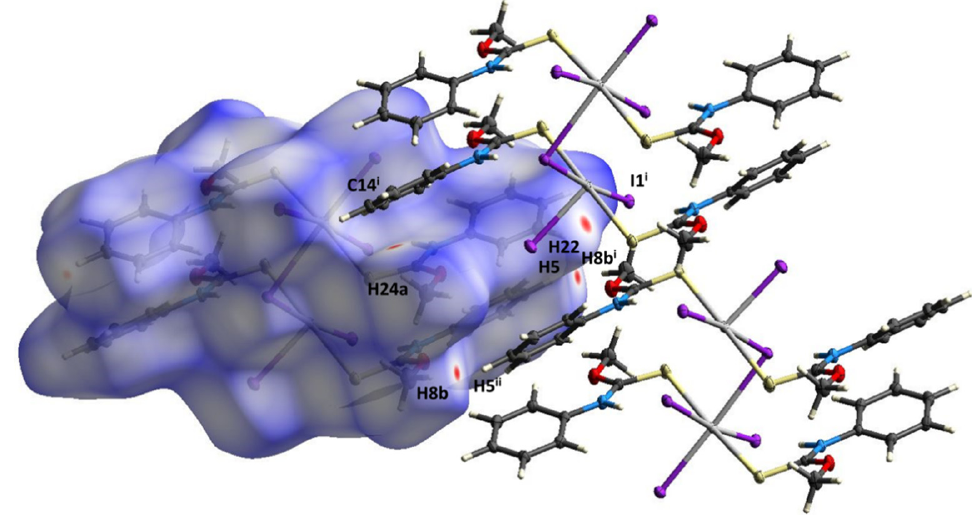
Figure 4. View of the Hirshfeld surface of compound 1 revealing some loose contacts in the crystal structure. Molecule i was generated by the symmetry operation 1+ x , + y , + z and molecule ii by the symmetry operation 1- x , 1- y , 2- z .